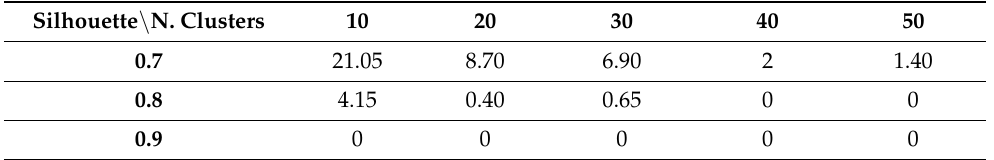
Table 35. Clustering performance in terms of silhouettes using the reduced dataset with PCA applied to normalized data. Silhouette \ N.